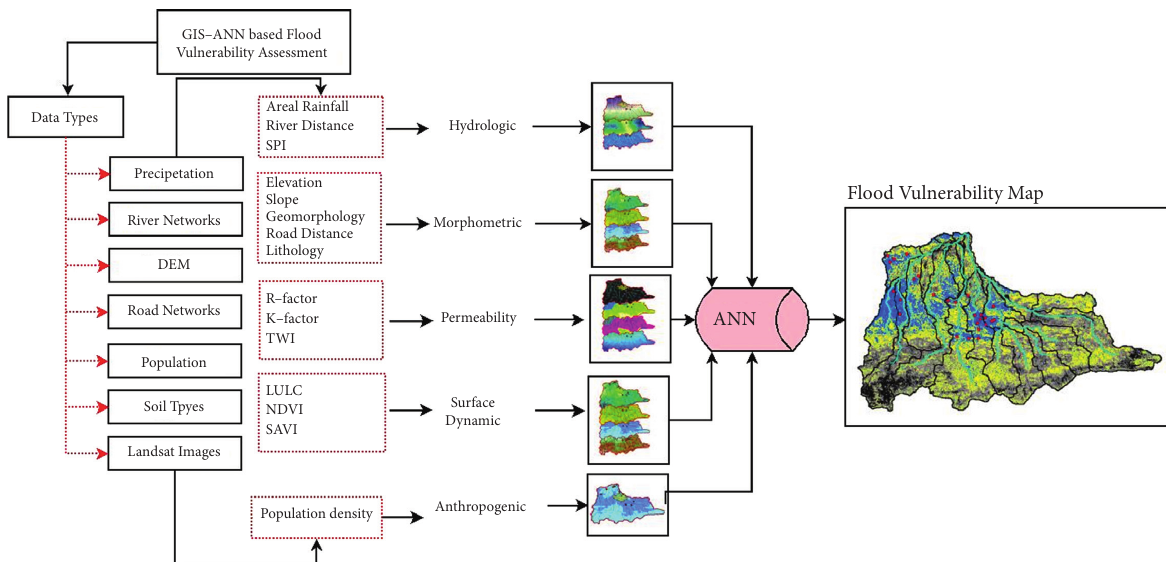
Figure 5: General flowchart of the study.